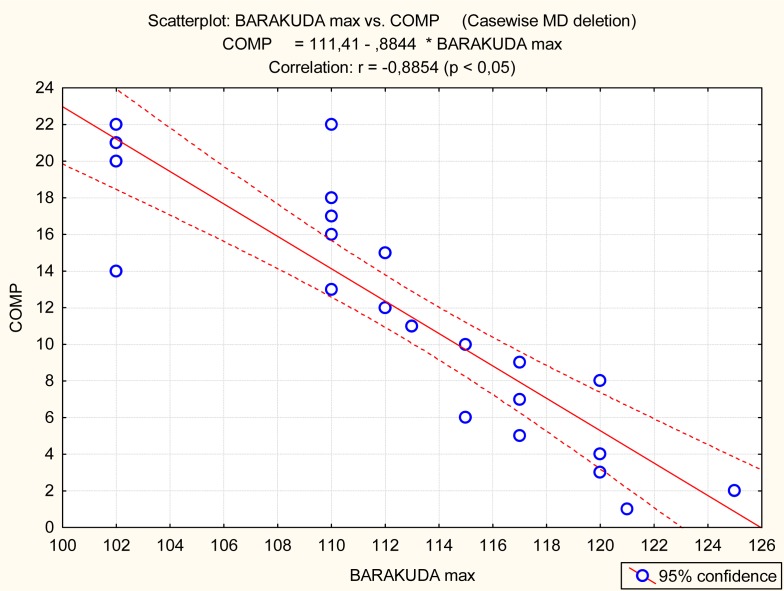
Graphical presentation of the relationship between Barracuda (BARAKUDA max) and competitive achievement (COMP)